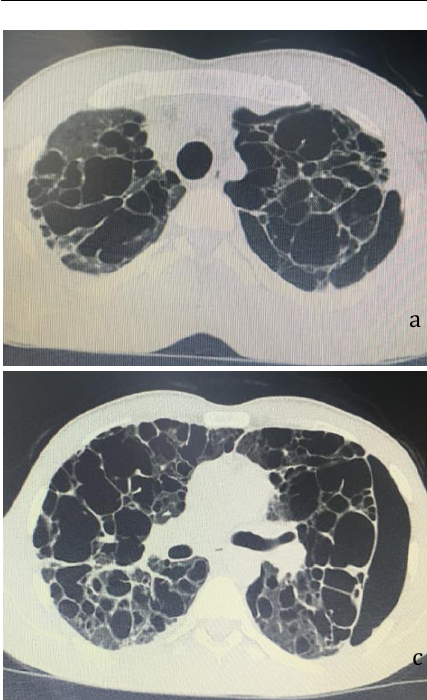
Figure 1 (a, b, c, d). Multiple bizarre-shaped pulmonary cysts in both lungs with more involvement of upper and mid zones and left side